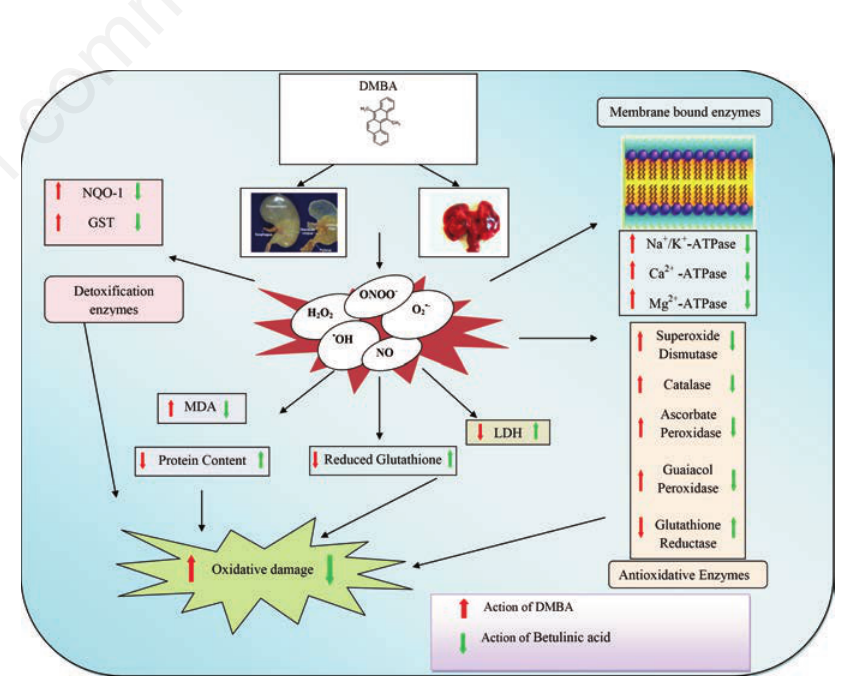
Figure 2. Overall schematic representation of Betulinic acid mediated modulation of DMBA evoked extrahepatic oxidative